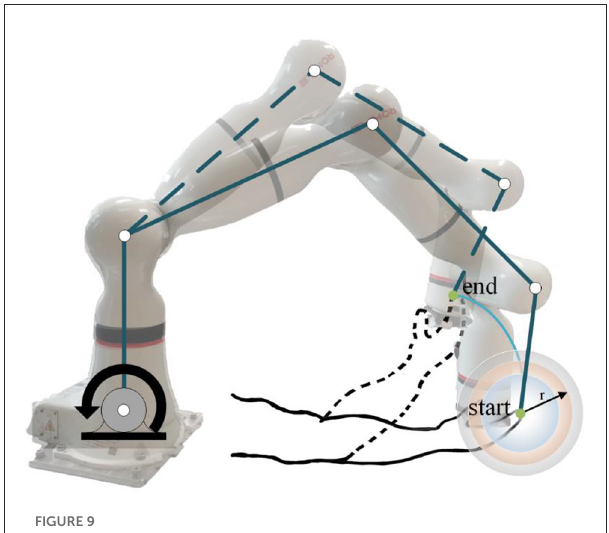
FIGURE9 The control outcome of